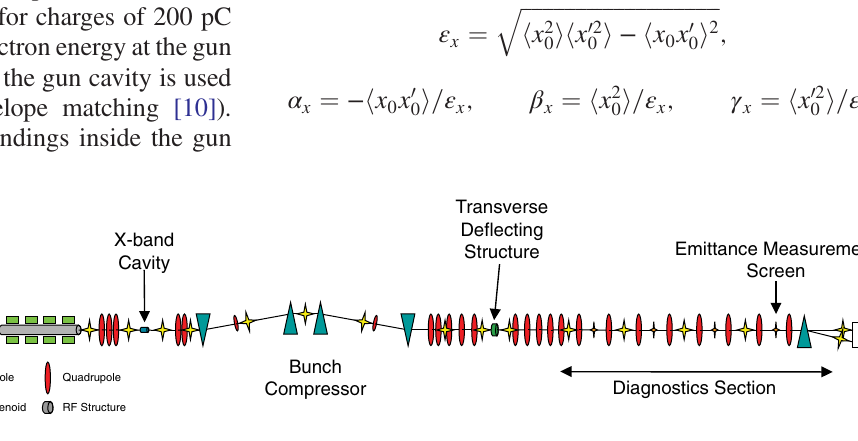
FIG. 2. Schematic layout of the SwissFEL Injector Test Facility (not to scale). The total length is about 60